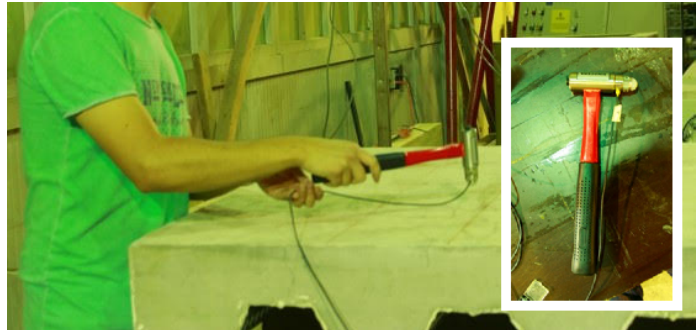
Figure 5. Plan view of slab with numbering of excited points. Unit: mm.